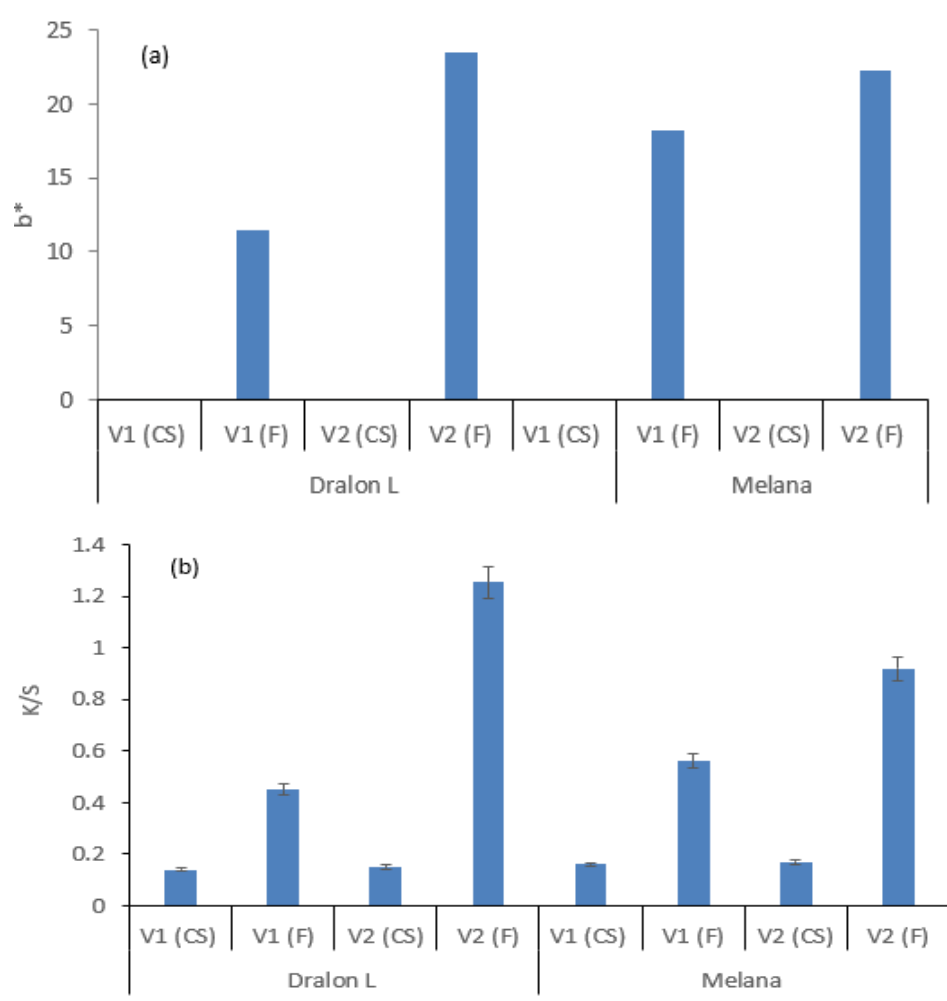
Figure 15. Colorimetric measurements on control sample (CS) and functionalized (F) Melana and Dralon L: ( a ) b* values; ( b ) K/S, color intensity.